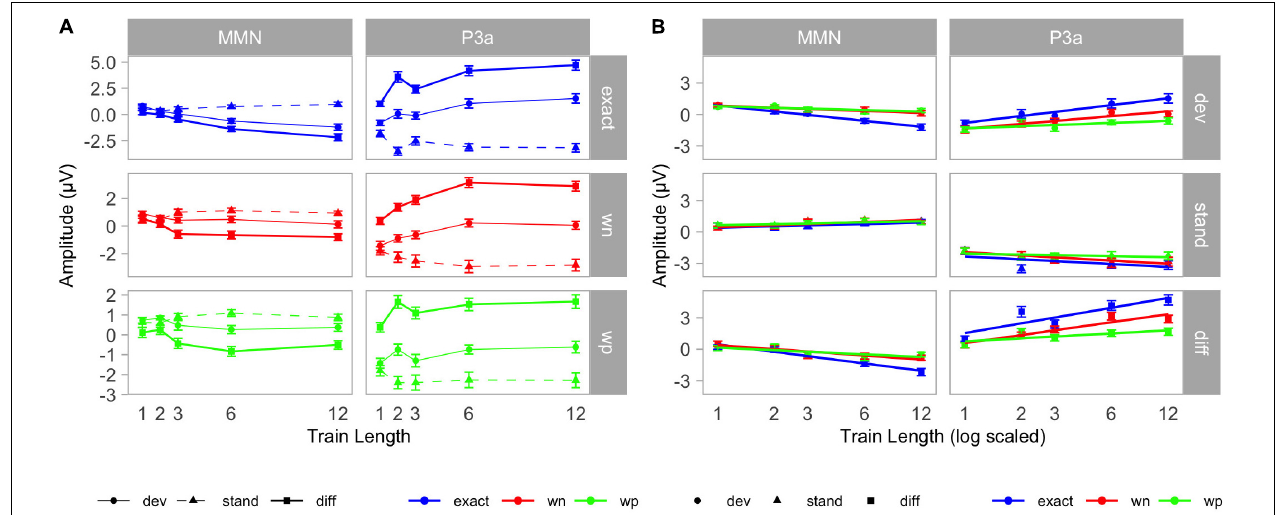
FIGURE 5 | (A) Grand-averaged mean amplitudes in the mismatch negativity (MMN) ( left) and P3a (right) time windows. ERPs were elicited by standards (triangles/dashed lines) and deviants (points/solid thin lines). Difference wave amplitudes (deviant minus standard) are shown by rectangles and solid thick lines. Results are plotted condition-wise ( top : exact/blue, middle : wn/red, bottom : wp/green). Whiskers denote standard errors of the mean. (B) Logarithmic regression analysis. Mean amplitudes in the MMN ( left ) and P3a ( right ) time windows. Results are plotted stimulus-type wise ( top : deviants/points; middle : standards/triangles; bottom: differences/rectangle). Conditions are indicated by colors (exact: blue, wn: red, and wp: green). Whiskers denote standard errors of the mean. Train lengths are scaled logarithmically, and trend lines indicate the lines of the best fit.